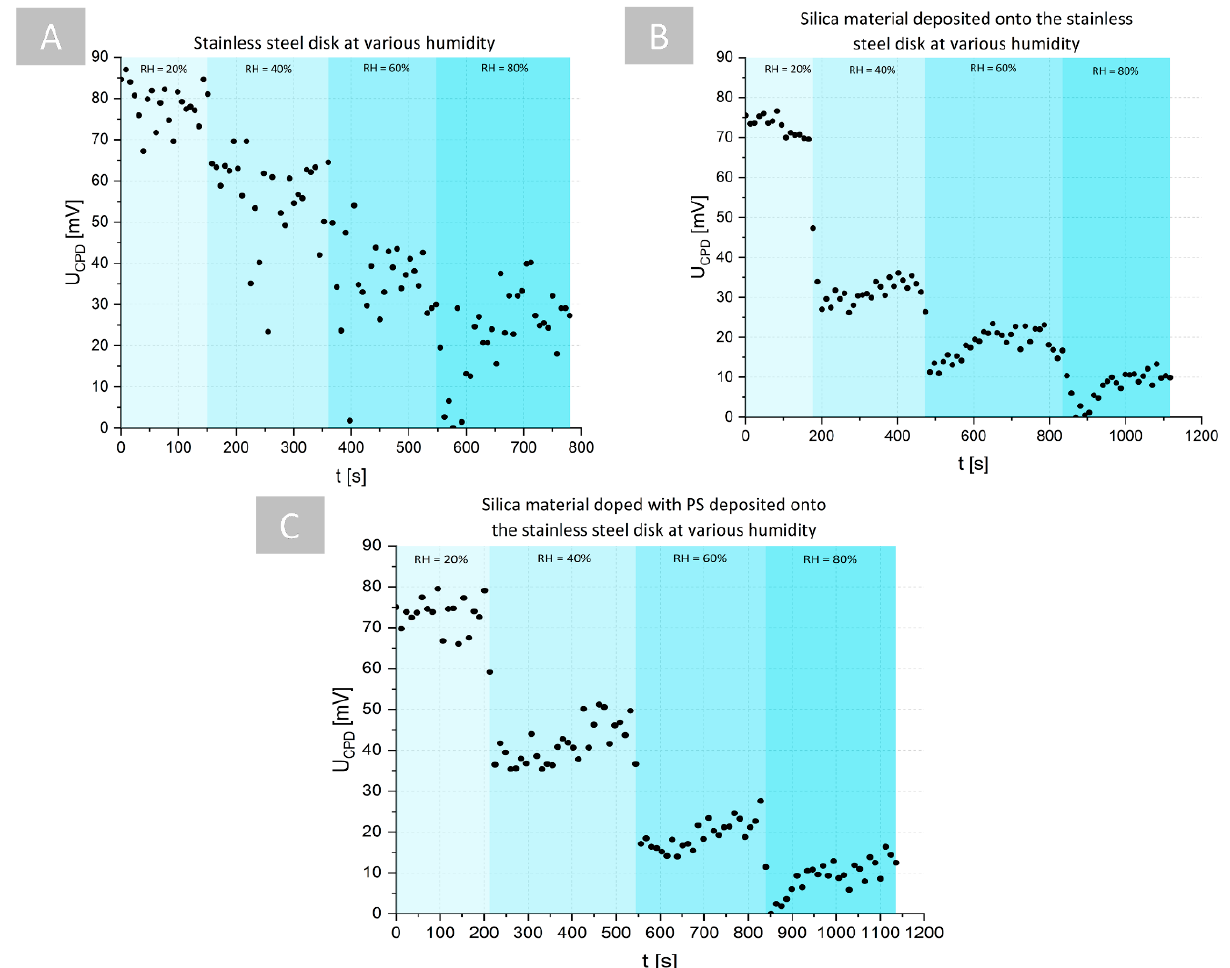
Figure 4. The influence of the relative humidity (RH) on the time-resolved U CPD measurements: ( A ) pure stainless steel, ( B ) silica material deposited on stainless steel, and ( C ) photoactive silica material deposited on stainless steel.